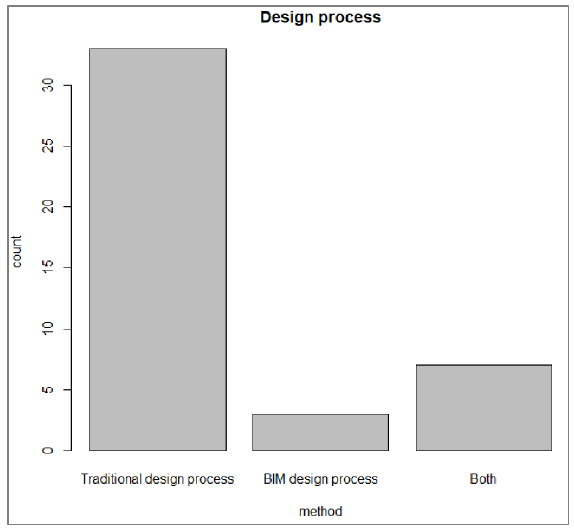
Figure 3. Design process.